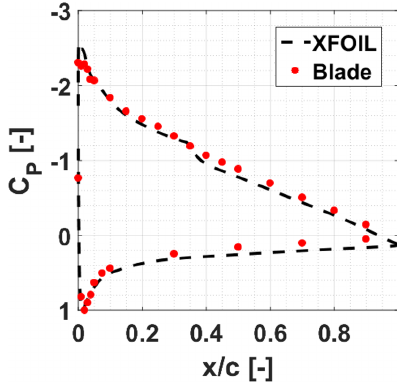
Figure 10. XFOIL ( α = 7 . 6 ◦ ) and measured pressure distribution of the current setup at a yaw angle of ψ = 0 ◦ , pitch angle of θ = 0 ◦ and azimuth angle of φ = 0 ◦